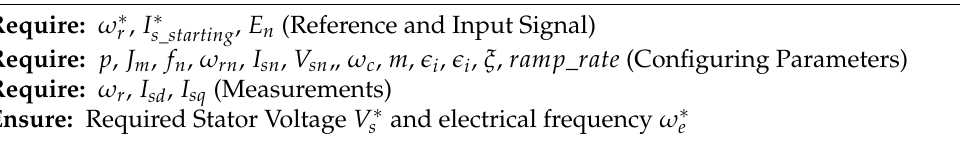
Algorithm 1 Pseudocode of the required voltage and frequency for the CL